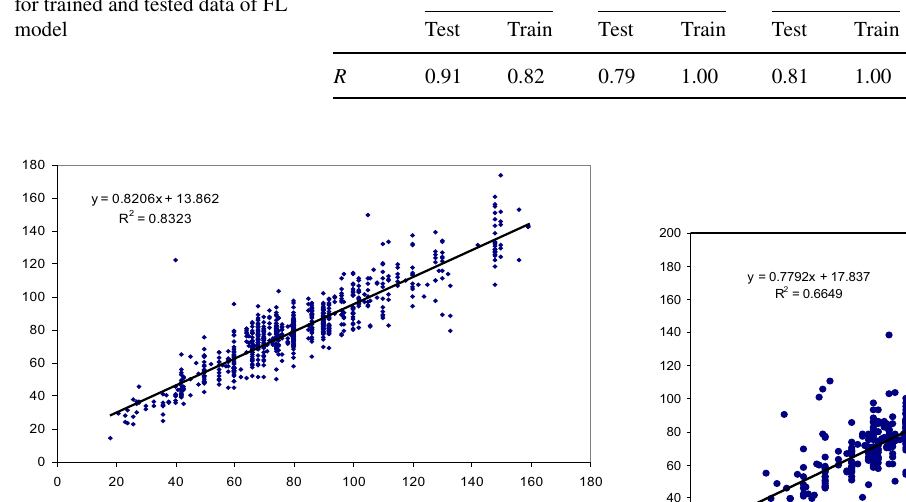
for trained and tested data of FL model